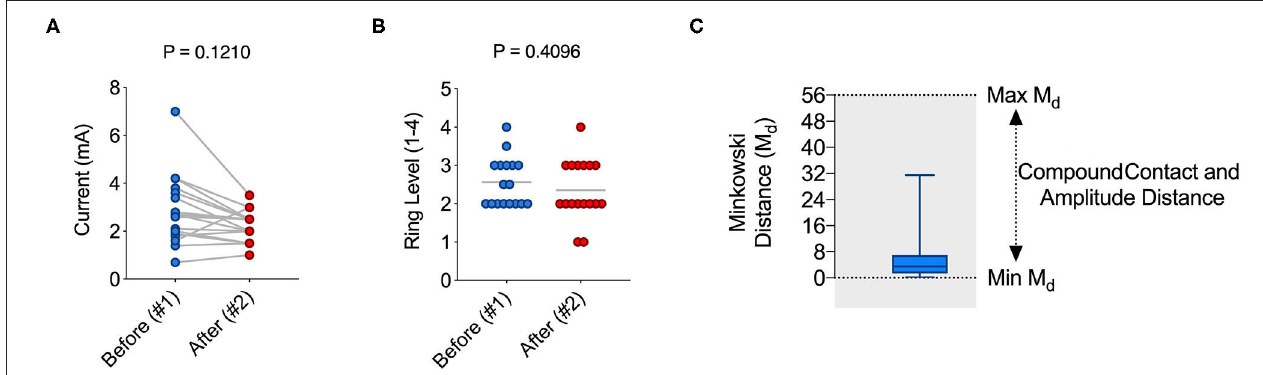
FIGURE 2 | VAS-based programming leads to similar contact and amplitude choices as standard clinical programming. (A) Graph illustrating the current in mA chosen in setting #1 (pre-VAS) and #2 (VAS) (mean ± s.e.m: 2.853 ± 0.3552 vs. 2.235 ± 0.1553; P > 0.05). (B) Graph illustrating the ring level height (1, 2, 3, or 4) on the electrode lead in setting #1 (pre-VAS) and #2 (VAS) (mean ± s.e.m: 2.853 ± 0.3552 vs. 2.235 ± 0.1553; P > 0.05). (C) Bar graph showing the mean ± s.e.m. Minkowsi distance (M d ) considering contact and amplitude between setting #1 and #2 (mean M d ± s.e.m.: 5.49 ± 7.49). For statistical comparison, an unpaired t -test has been used in (A,B) .